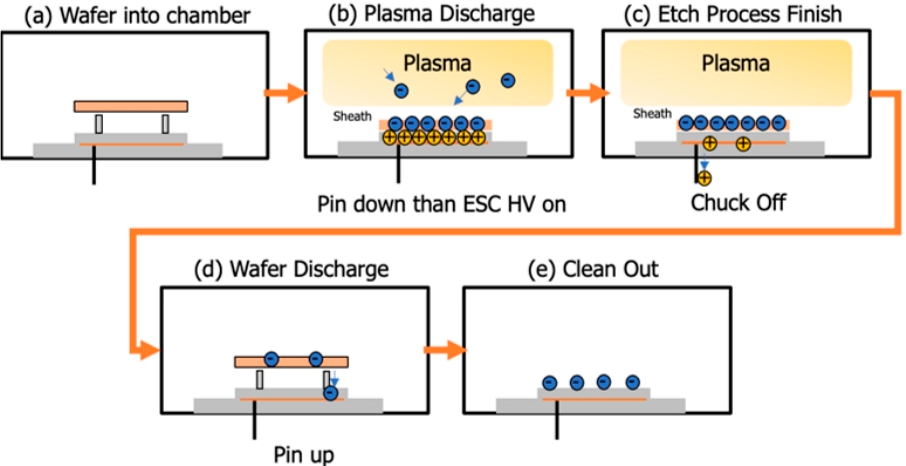
Figure 3. Plasma etching process. ( a ) Wafer in the chamber. ( b ) The pins are pushed down,